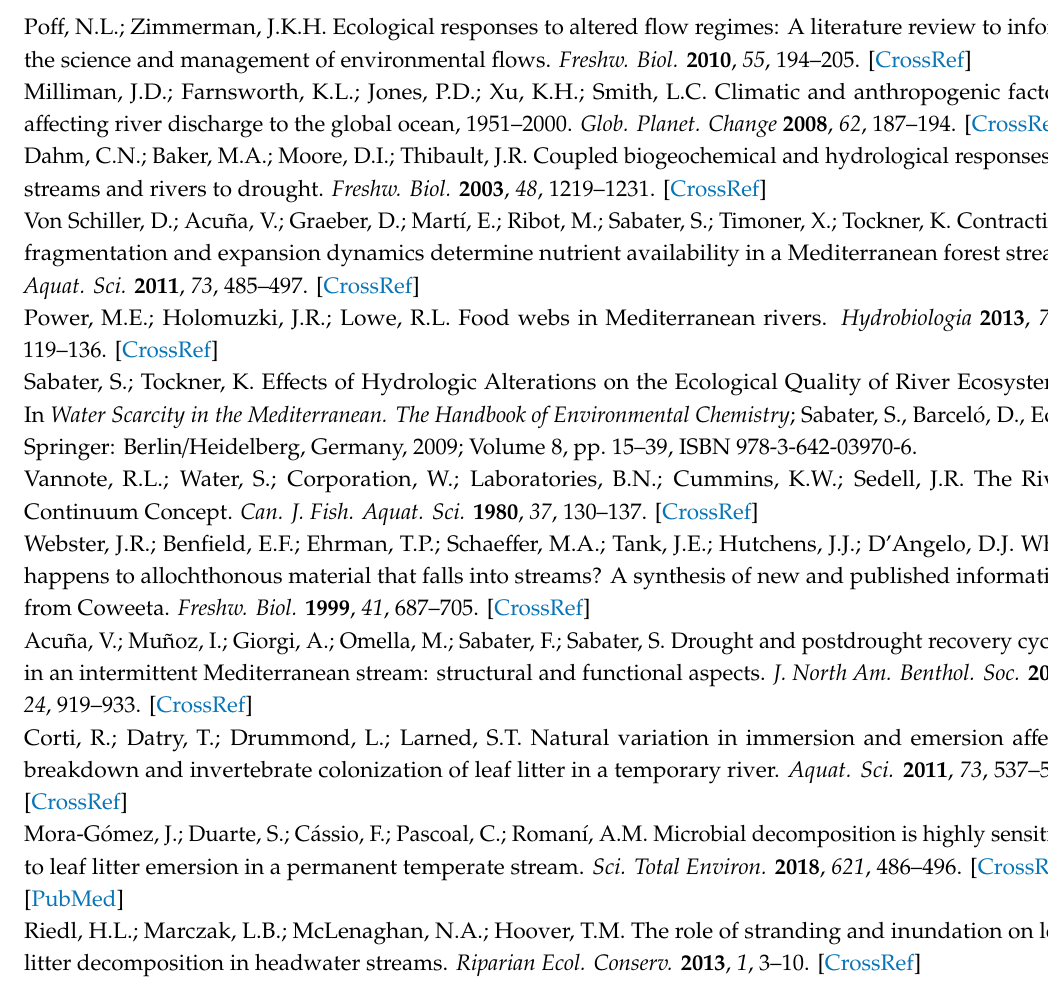
Figure S1: Dark net fluxes of O 2 , NH 4 + , PO 43 − , at day 10, 17 and 40. Table S1. Summary of results of two-way ANOVA testing the e ff ects of factors macrofauna and leaf size on benthic respiration (O 2 ) and nutrient fluxes (NH 4 + , PO 43 − ) measured on day 10. Table S2. Summary of results of two-way ANOVA testing the e ff ects of factors macrofauna and leaf size on benthic respiration (O 2 ) and nutrient fluxes (NH 4 + , PO 43 − ) measured on day 17. Table S3. Summary of results of three-way ANOVA testing the e ff ects of factors macrofauna, leaf size and drying on benthic respiration (O 2 ) and nutrient fluxes (NH 4 + , PO 43 − ) measured on day